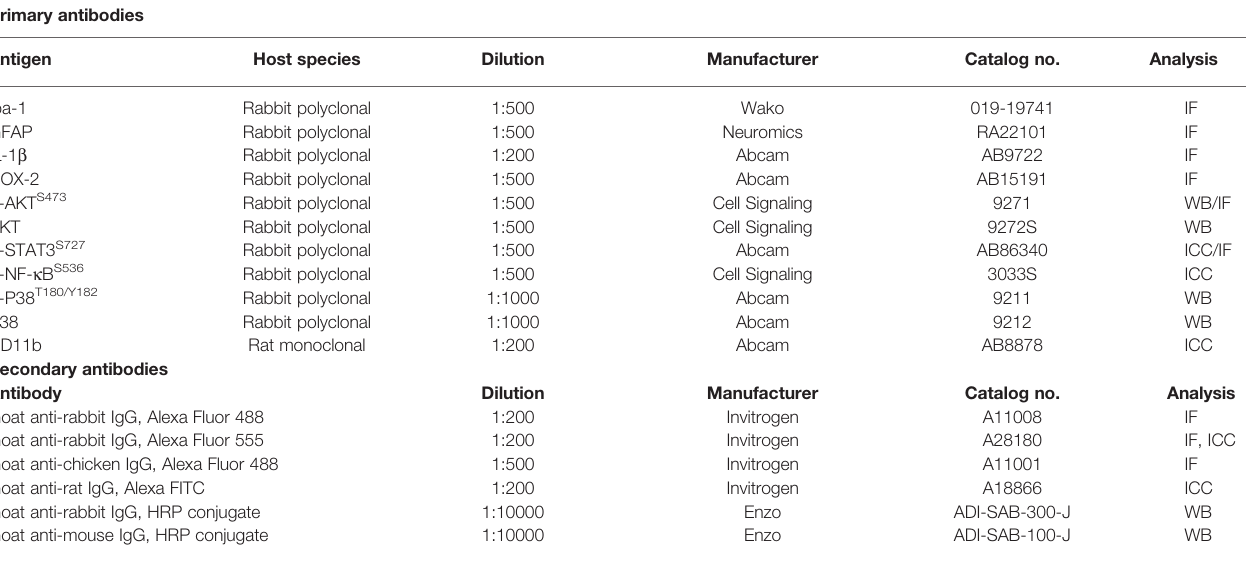
TABLE 3 | List of antibodies used in this